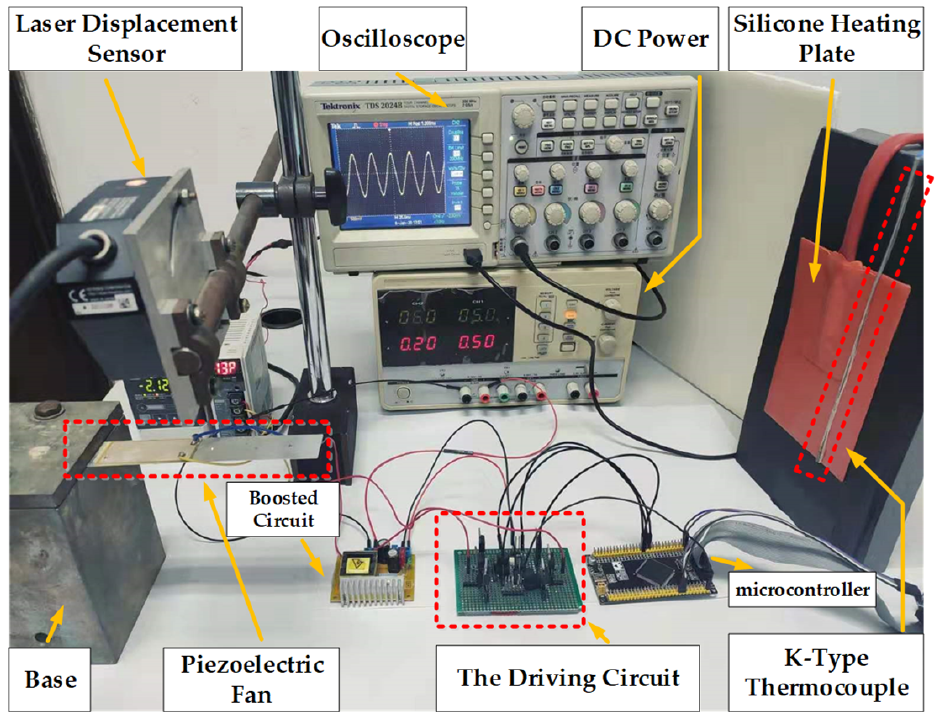
Figure 12. The experimental setup. Table 1. Parameters of the proposed circuit.